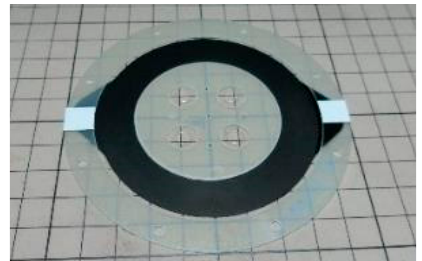
Figure 2. Circular DE cartridge.